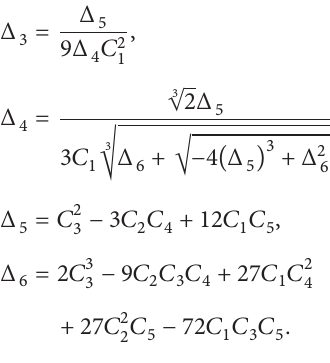
= 50 Ω , 𝑅 = 60Ω , and 𝑝 = 2.2 𝑆 𝐿